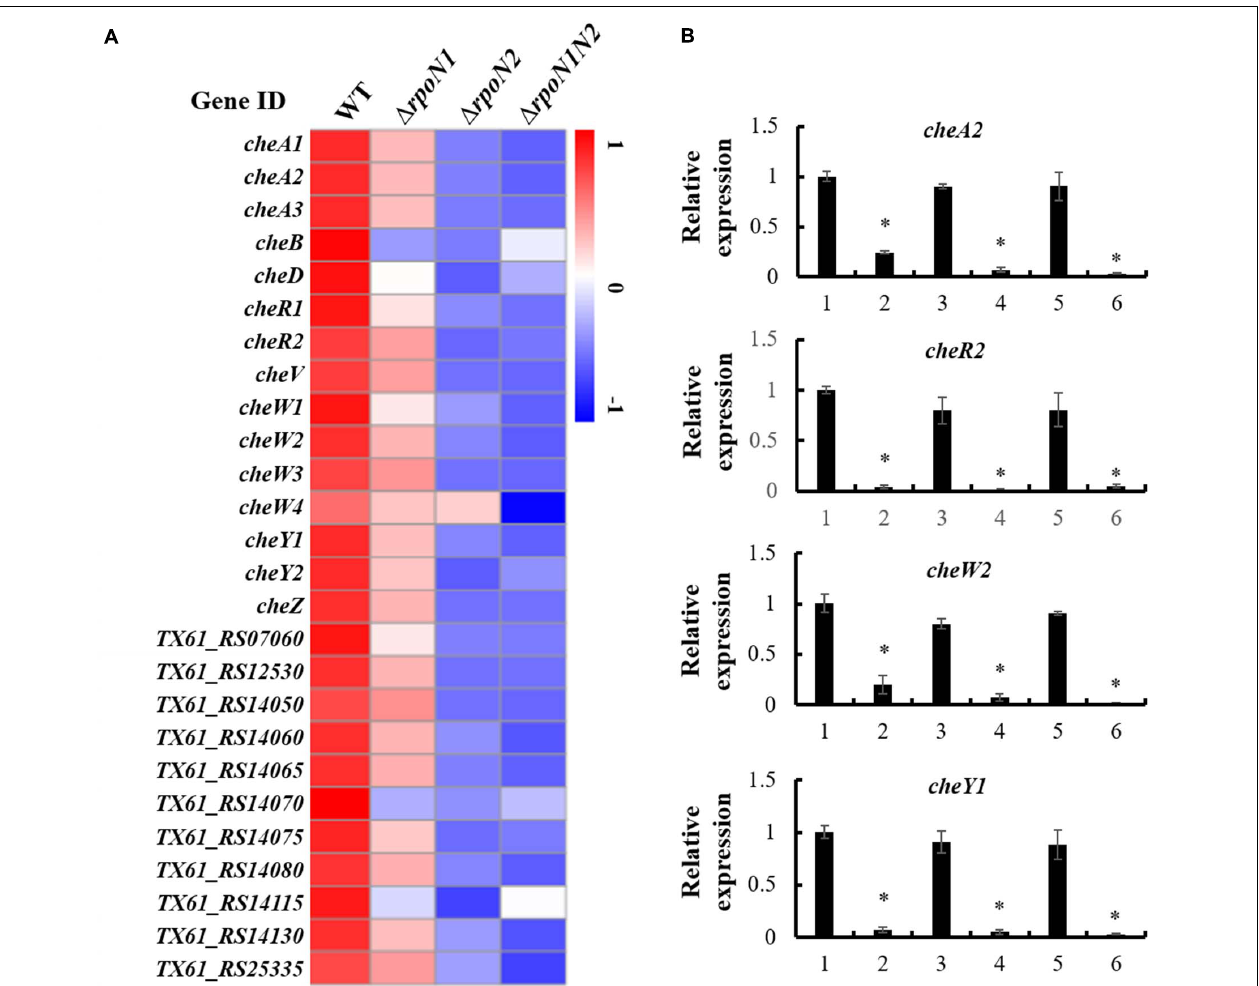
FIGURE 7 | RpoN1 and RpoN2 regulated chemotaxis associated genes. (A) Heat map of gene expression of chemotaxis genes. (B) The expression patterns of cheA2 , cheR2 , cheW2, and cheY1 in (cid:49) rpoN1 , (cid:49) rpoN2, and (cid:49) rpoN1N2 were validated using qRT-PCR. 1, WT; 2, (cid:49) rpoN1 ; 3, (cid:49) rpoN1 -C; 4, (cid:49) rpoN2 ; 5, (cid:49) rpoN2 -C; 6, (cid:49) rpoN1N2 . Asterisks indicate significant differences between WT and mutants ( P -value < 0.05) (Student’s t